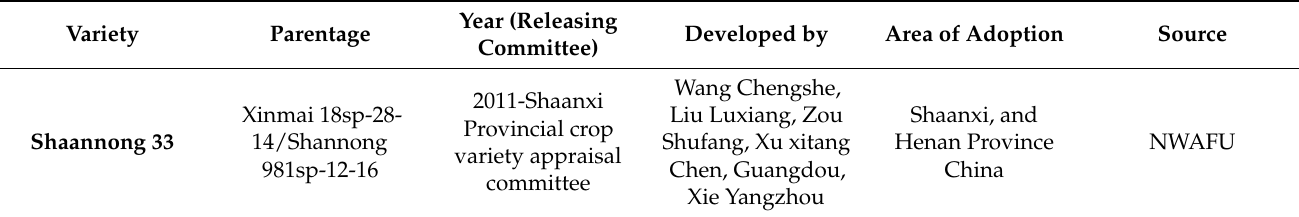
Table 4. Detail of the wheat varieties used in this